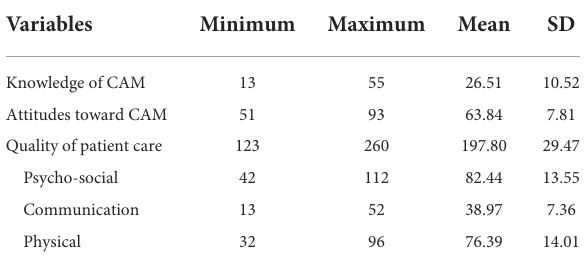
TABLE 2 The distribution of knowledge of CAM score, attitudes toward CAM score, and quality of nursing care and its dimensions’ scores ( n =